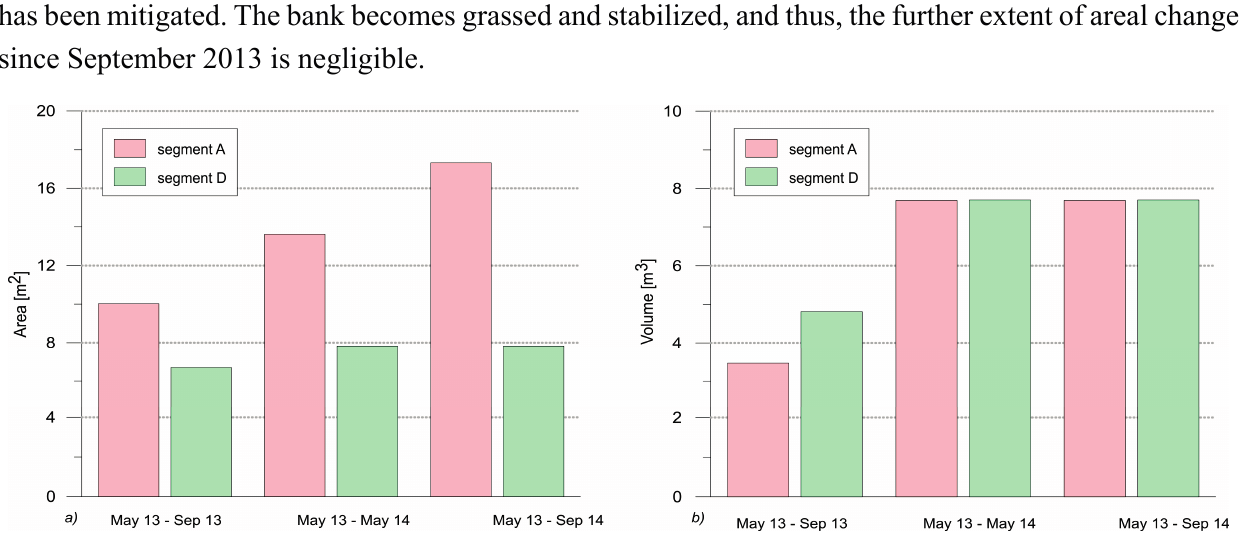
Figure 10. Cumulative erosion rate at segments A and D. ( a ) Accumulated area change; ( b ) Accumulated volumetric